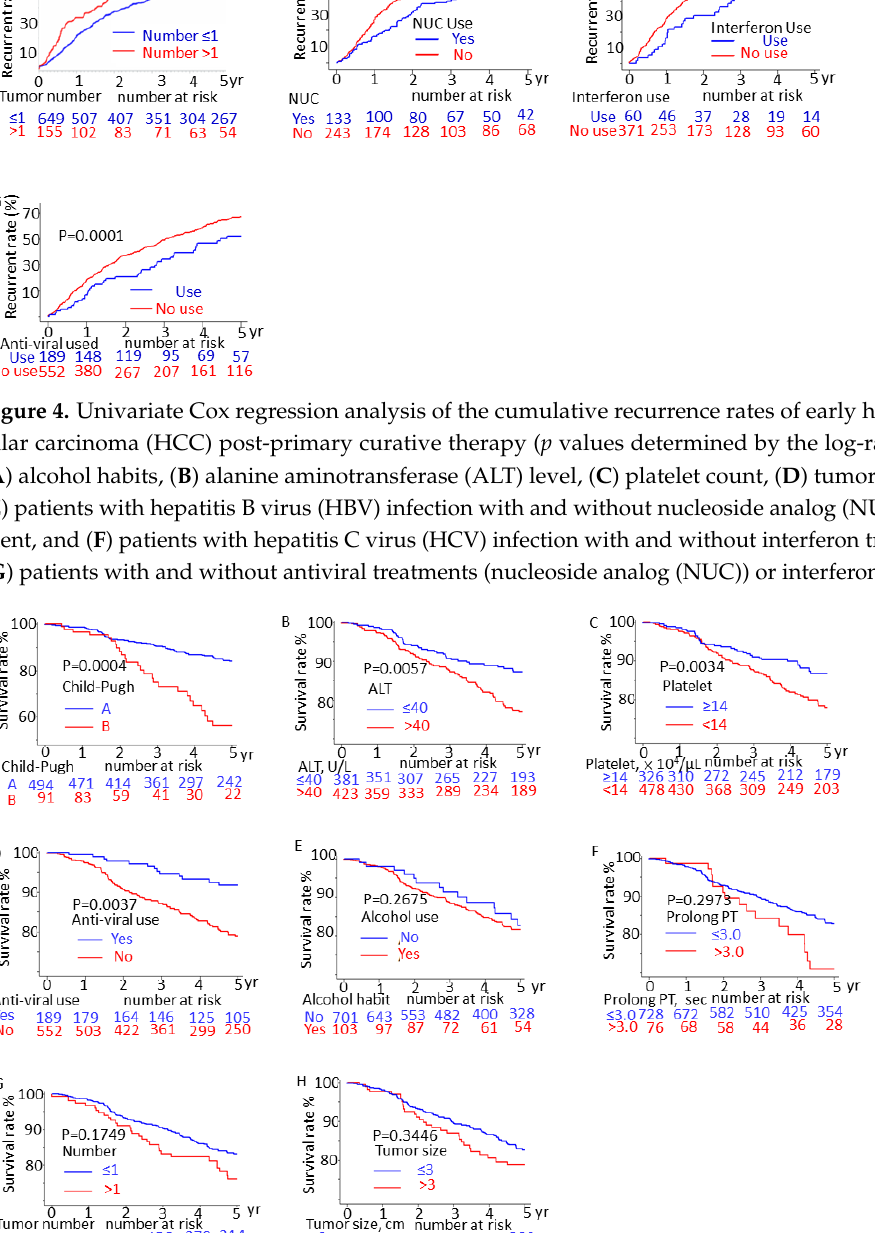
Figure 5. Effects of risk factors on five-year survival rates in early stage HCC (BCLC stage 0-A) with recurrence after curative treatment (log-rank test): ( A ) Child – Pugh scores, ( B ) aspartate aminotransferase (ALT) level, ( C ) platelet count, ( D ) with and without therapy antiviral agents (nucleoside analog or interferon), ( E ) alcohol habits, ( F ) prothrombin time (PT), ( G ) tumor number, and ( H ) tumor size.